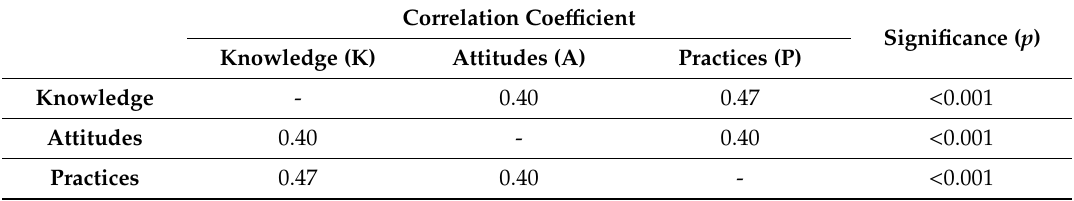
Table 3. Correlations among KAP of elderly people in oral care (n =